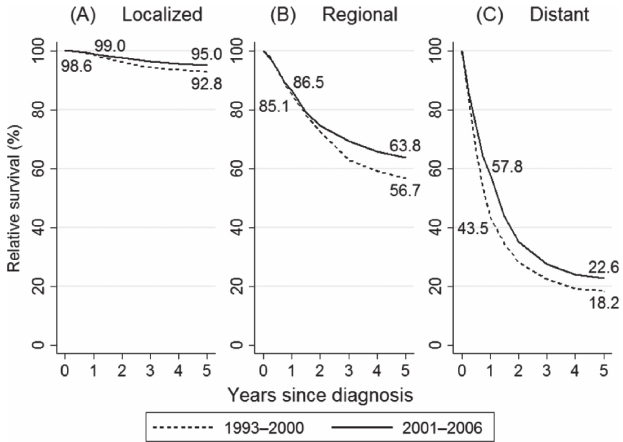
Figure 1. Relative survival of patients with cancer of the corpus uteri by extent of disease in the 1st period (1993 – 2001) and the 2nd period (2001 – 2006). Dashed line, relative survival curve in the 1st period (1993 – 2000); solid line, relative survival curve in the 2nd period (2001 – 2006). (A) RS in the localized group. One-year RS of 1st and 2nd period were 98.6% and 99.0%. Five-year RS of 1st and 2nd period were 92.8% and 95.0%. (B) RS in the regional group. One-year RS of 1st and 2nd period were 85.1% and 86.5%. Five-year RS of 1st and 2nd period were 56.7% and 63.8%. (C) RS in the distant group. One-year RS of 1st and 2nd period were 43.5% and 57.8%. Five-year RS of 1st and 2nd period were 18.2% and 22.6%. RS, relative